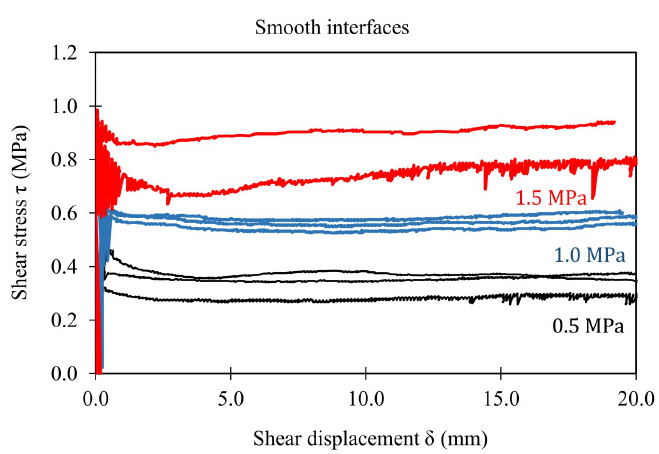
Figure 5. Shear stress evolution for tests with a smooth